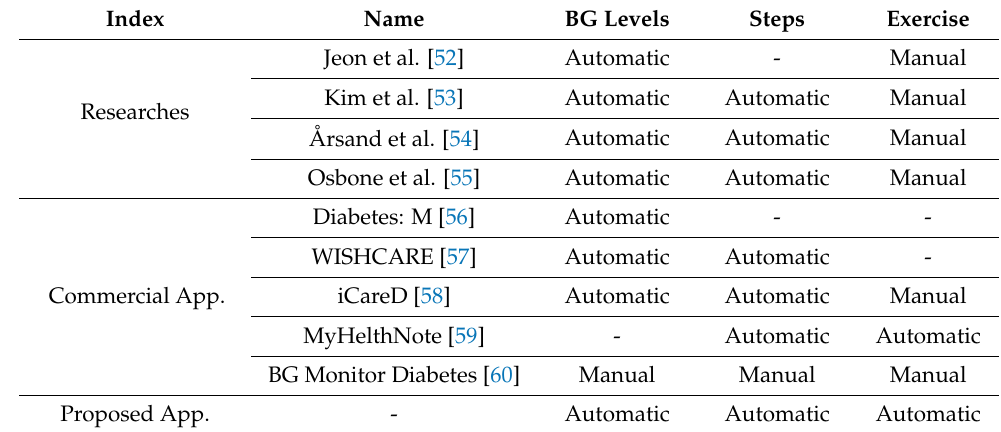
Table 6. Comparison results between the proposed application and the conventional